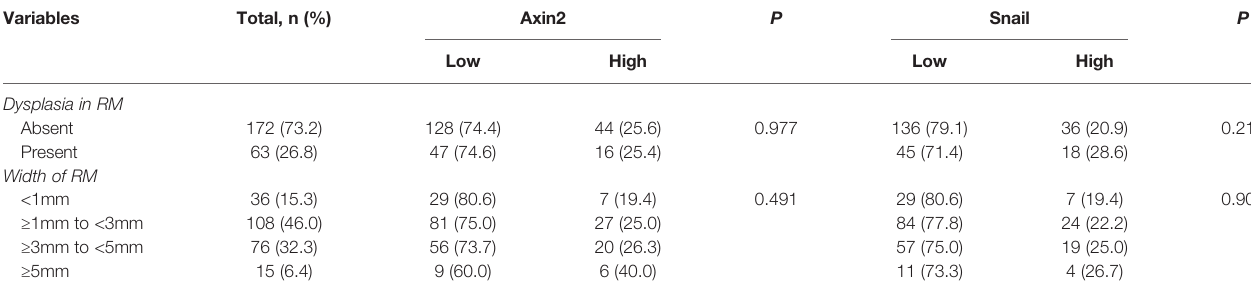
TABLE 2 | Association between status of surgical margin and both Axin2 and Snail expression in 235 OSCC surgical margins. Variables Total, n (%) Axin2 P Snail P Low High Low High Dysplasia in RM